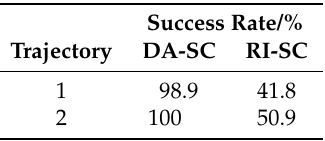
Table 1. Comparison between success rates at the first attempt of the two self-calibration methods Direction Adjudgment (DA-SC) and Random Initialization (RI-SC).